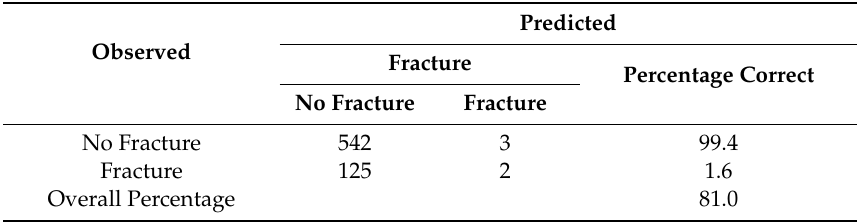
Table 4. Classification Table showing predictive power of